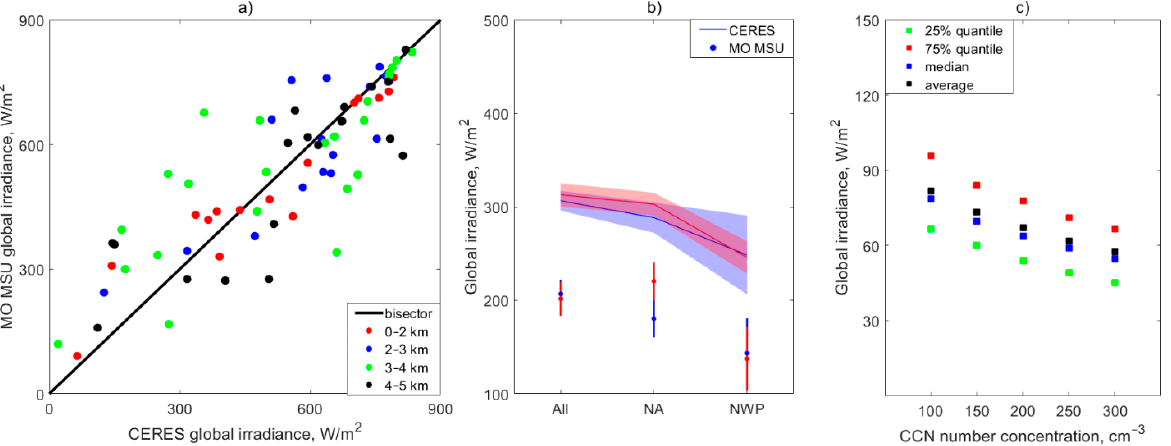
Figure 7. Observed and simulated global irradiance at ground: ( a ) CERES and MO MSU synchronous data (color indicates the distance between observations points); ( b ) CERES data over Moscow region (the same samples as for Figure 6e–f) and ground-based MO MSU global irradiance for three samples (data for 2020 is marked by red, for 2018–2019—by blue colors); ( c ) simulated global irradiance in dependence on N ccn for LWP = 200–400 gm − 2 for overcast condition. Solar height is equal 40º.